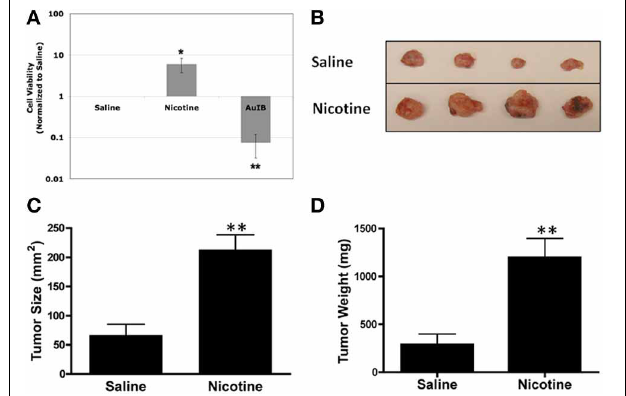
FIGURE 2 | Pharmacological activation or inhibition of nAChRs modulates SCLC growth. (A) DMS-53 cells were treated daily for 1 week with 1 μ M nicotine or 2 μ M α -conotoxin AuIB. Cell viability assays show that nicotine increases while AuIB decreases SCLC cell viability (values normalized to saline control; ∗ p < 0 . 05, ∗∗ p < 0 . 01). (B) DMS-53 cells were injected subcutaneously into the hind flanks of athymic nude mice. Mice were then implanted with osmotic minipumps that delivered either saline or 24mg/kg of nicotine daily. Tumors were harvested after 1 month (representative images shown). (C,D) . Chronic nicotine exposure increased both tumor size and weight ( ∗∗ p < 0 . 01, Student’s t